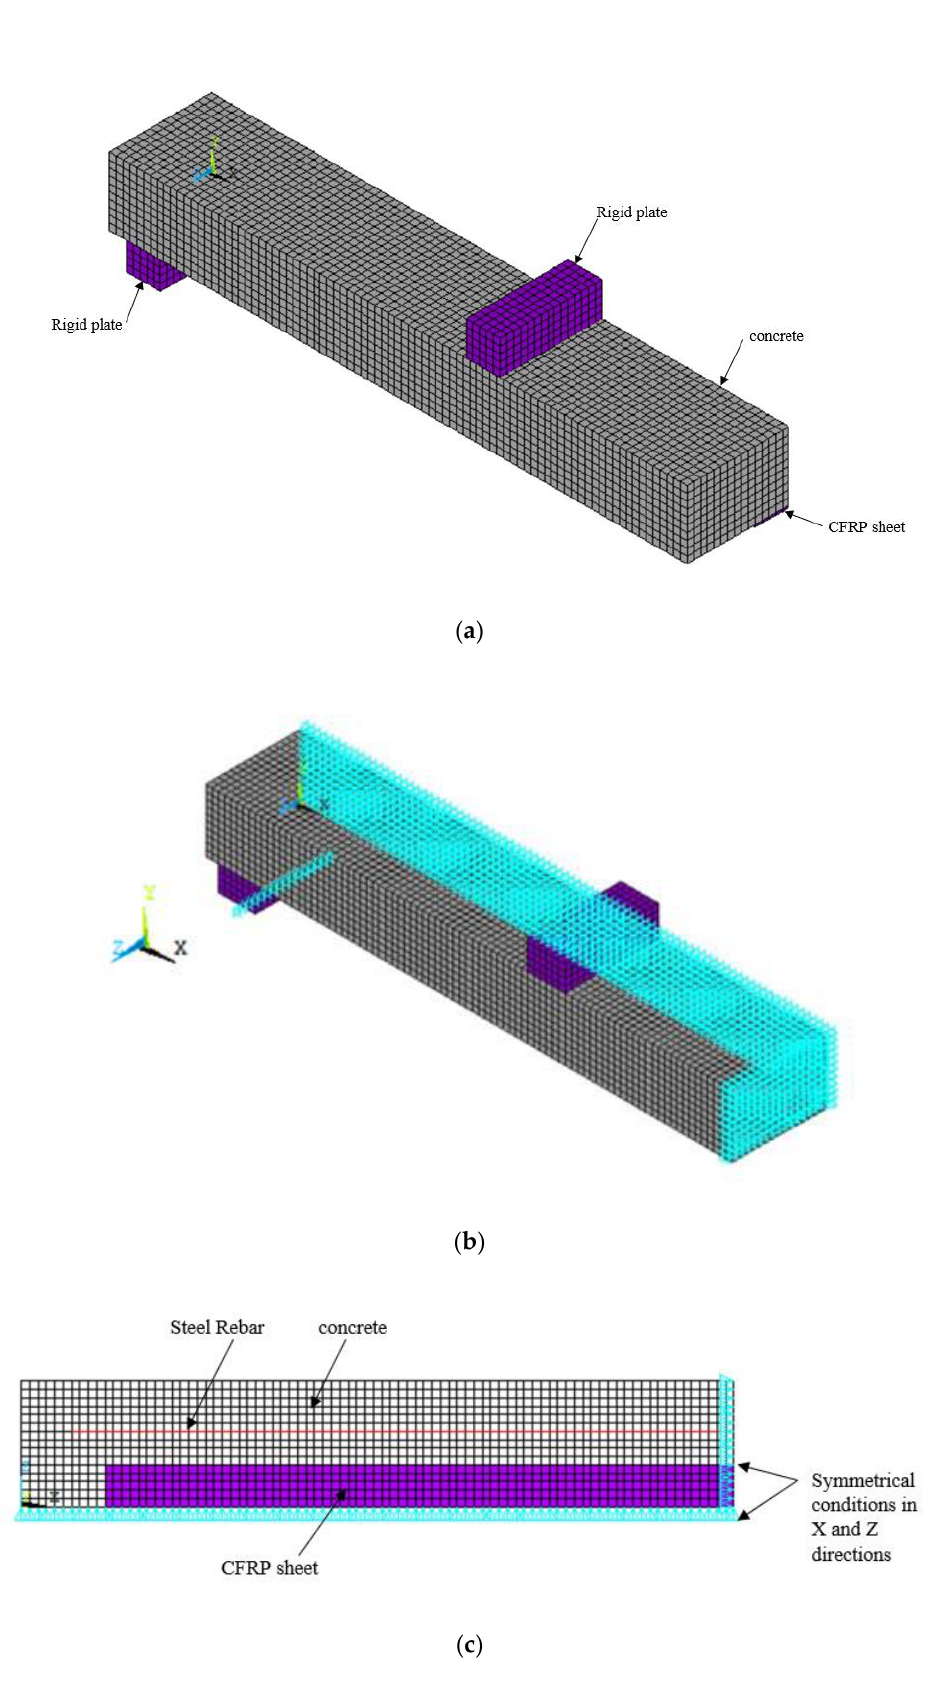
Figure 2. Developed FE model components in ANSYS: ( a ) 3D view; ( b ) boundary conditions; ( c ) bottom view.